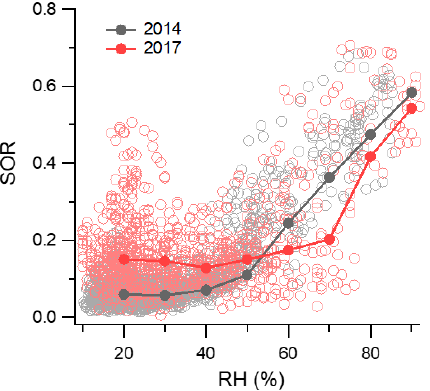
Figure 8. Variations in sulfur oxidation ratio (SOR) plotted against increasing RH. The data are also binned according to RH values, with the median value shown for each